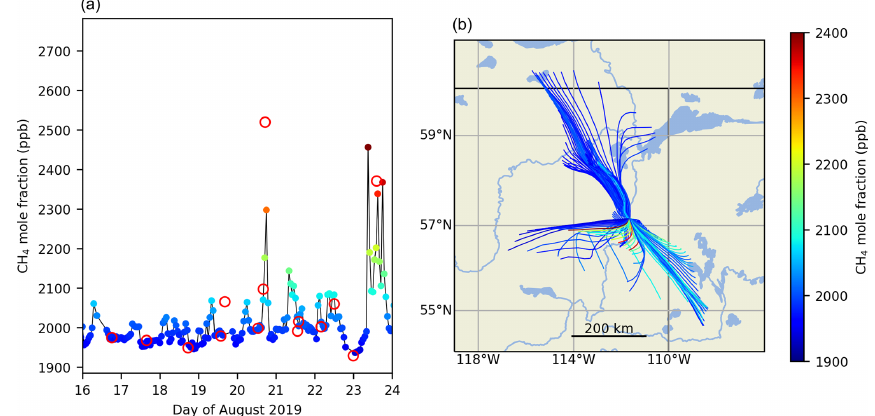
Figure 2. (a) Hourly CH 4 dry air mole fraction measurements at the FMS13 station (Fort McKay South), with the CH 4 mole fraction of the collected air samples in red circles. (b) HYSPLIT 12h back-trajectories associated with hourly measurements, with the colour scale representing CH 4 dry air mole fractions in both panels.